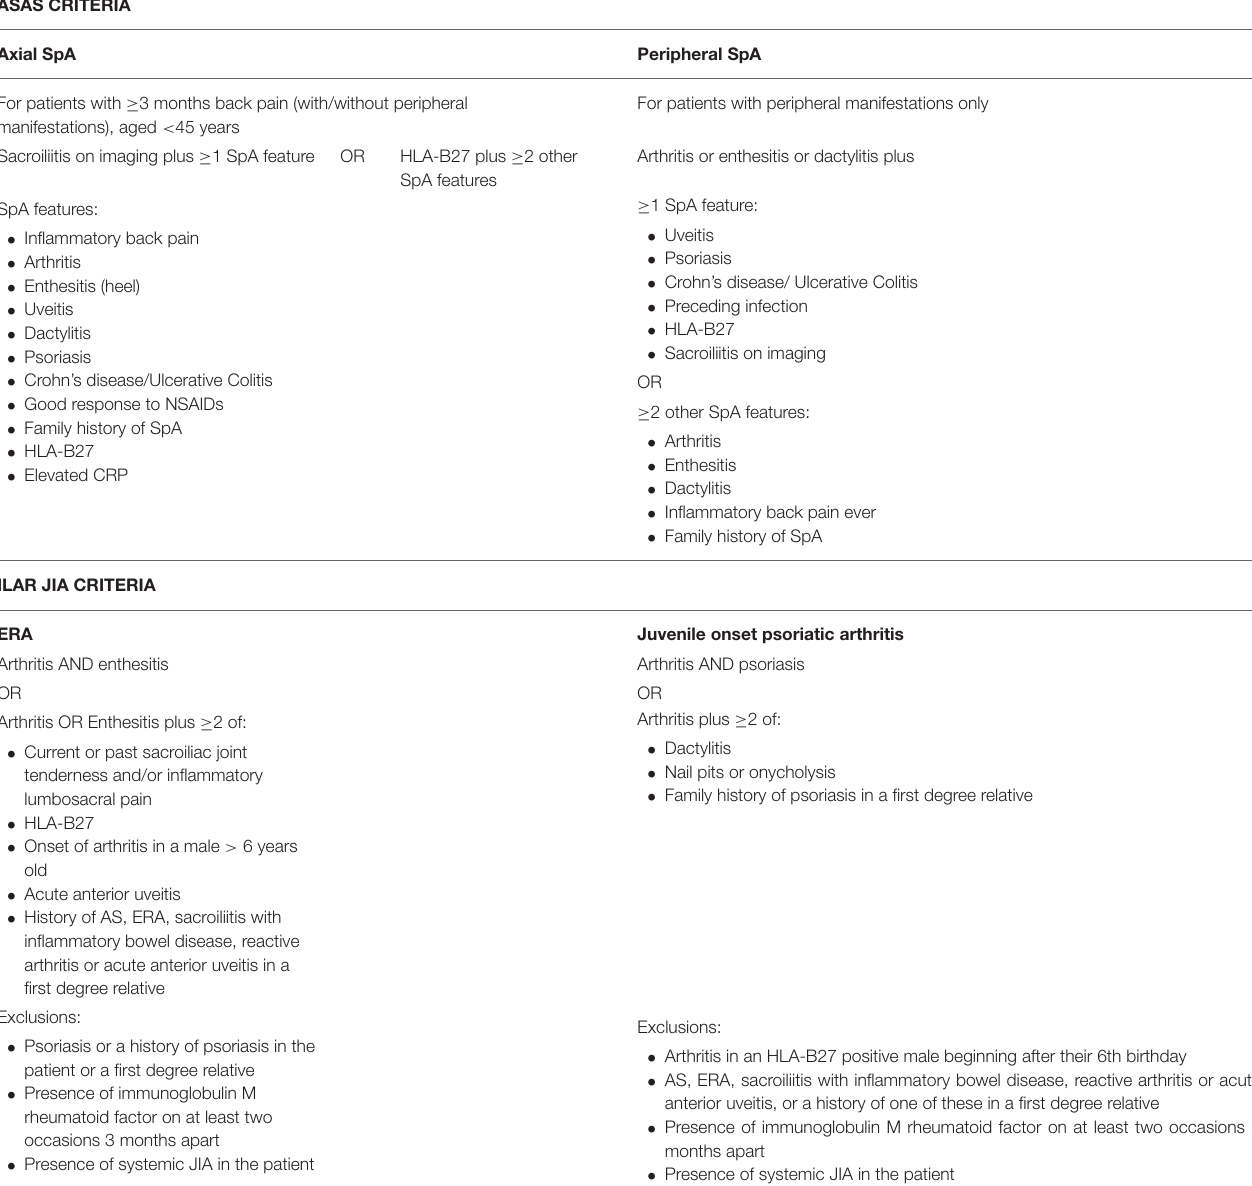
TABLE 1 | Classification criteria for the diagnosis of adult SpA and JSpA. ASAS